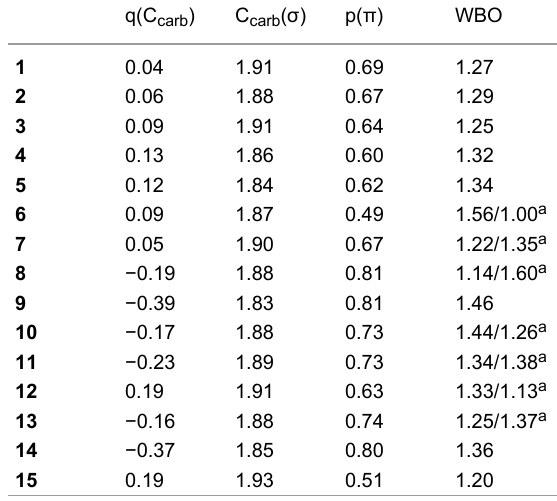
Table 1: Calculated NBO partial charges q(C carb ) of the carbene carbon atom, occupation of the lone pair orbital C carb ( σ ) and the p( π ) AO at C carb . Wiberg Bond Orders (WBO) for the C carb –X (X = C, N, O and S) bonds at BP86/def2-TZVPP.